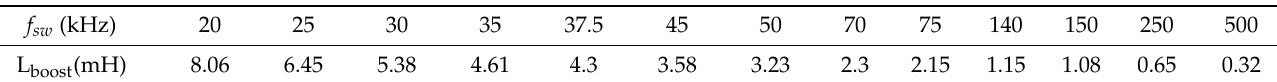
Table 2. Inductor Sizes For Single-Phase Unit In continuous conduction mode (CCM) Modes based On (5).